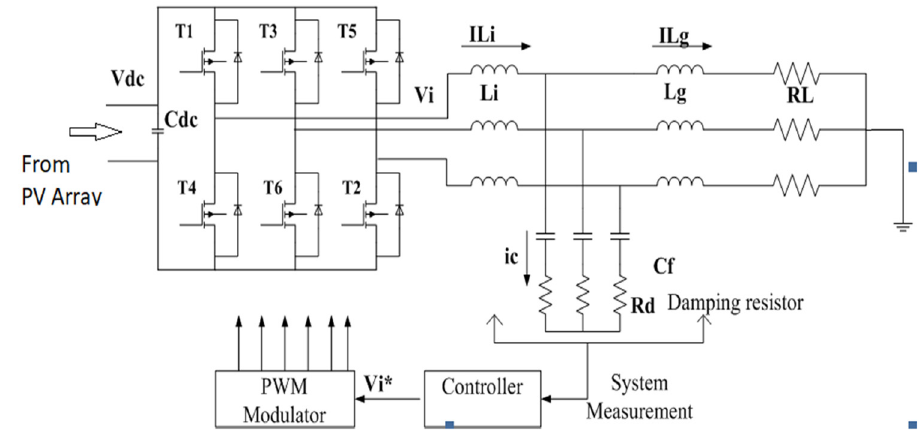
Figure 2: Standalone PV system with its control